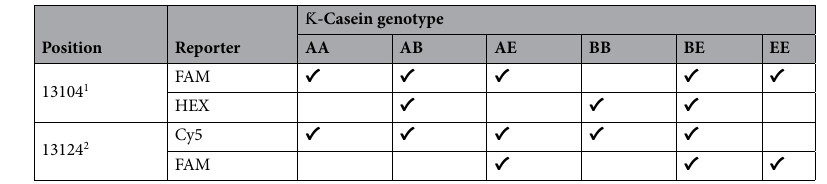
mined according to other preliminary studies 4,7 . A SYBR green-based qPCR assay was developed. A total reac-